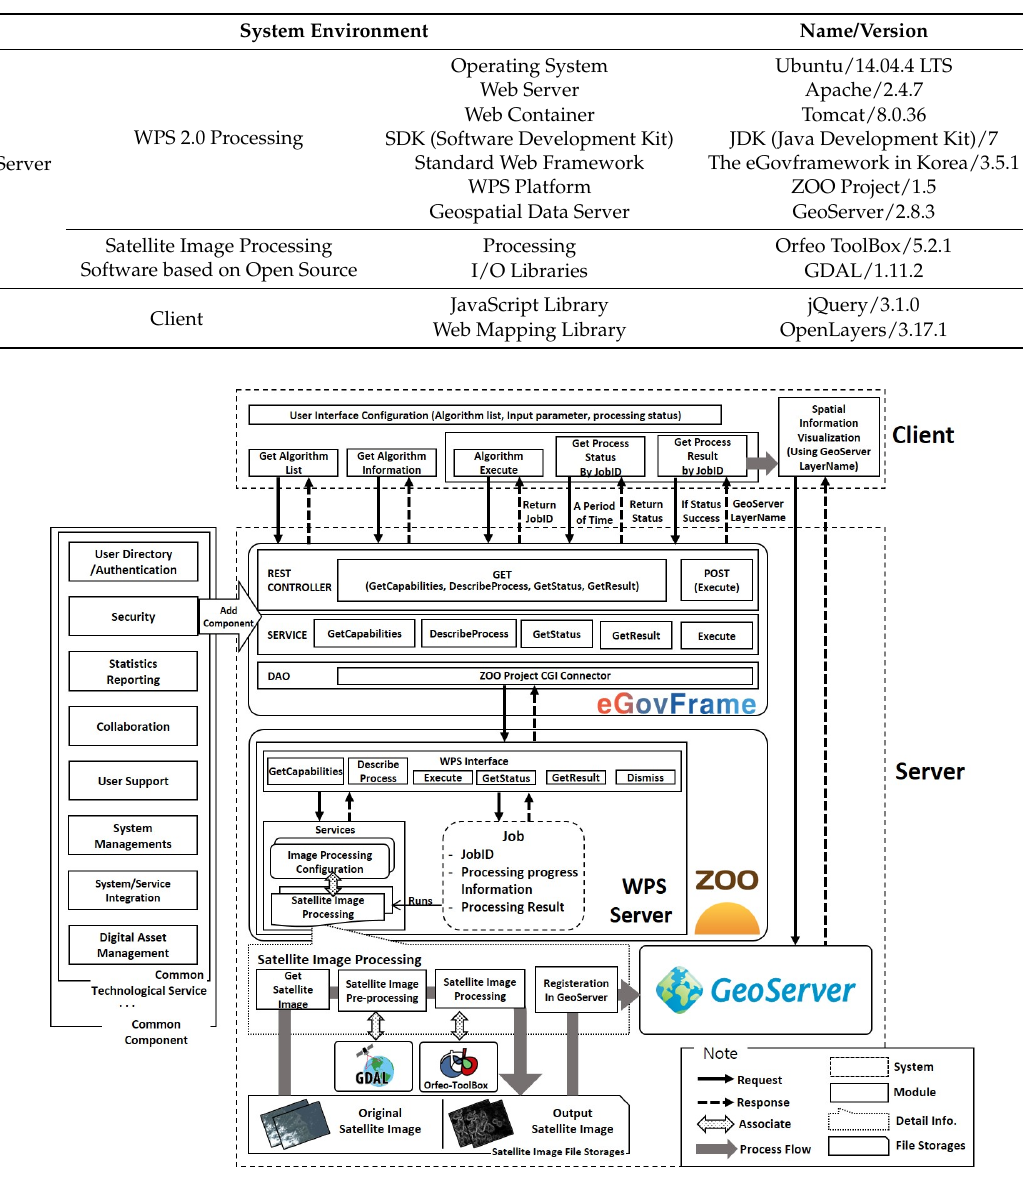
Table 2. Web Processing Service (WPS) 2.0 processing system based on the eGovframework using open source.